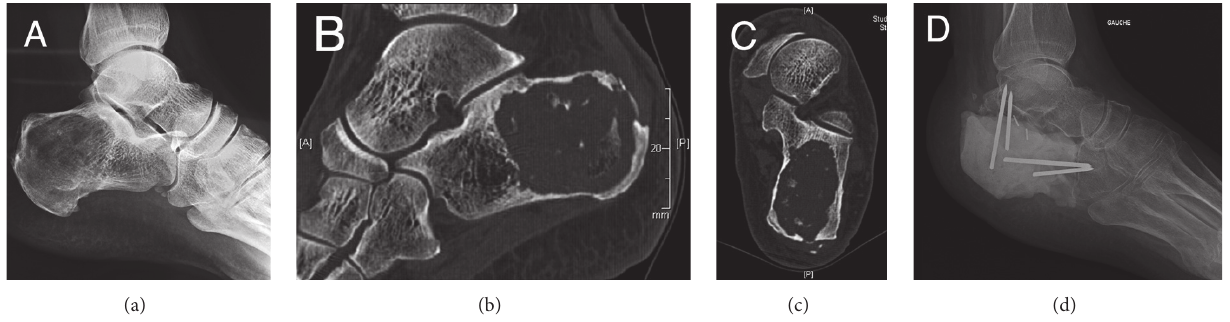
Figure 1: Clinical history: X-ray (a) and CT-scan (b and c) images of calcaneal chondrosarcoma showing a heterogeneous, lytic picture with intracystic calcifications. Visualization of a cortical rupture of the greater tuberosity with involvement of the Achilles tendon. Lateral X-ray (d) showing the spacer following calcanectomy with talocalcaneal and calcaneocuboid fixation.